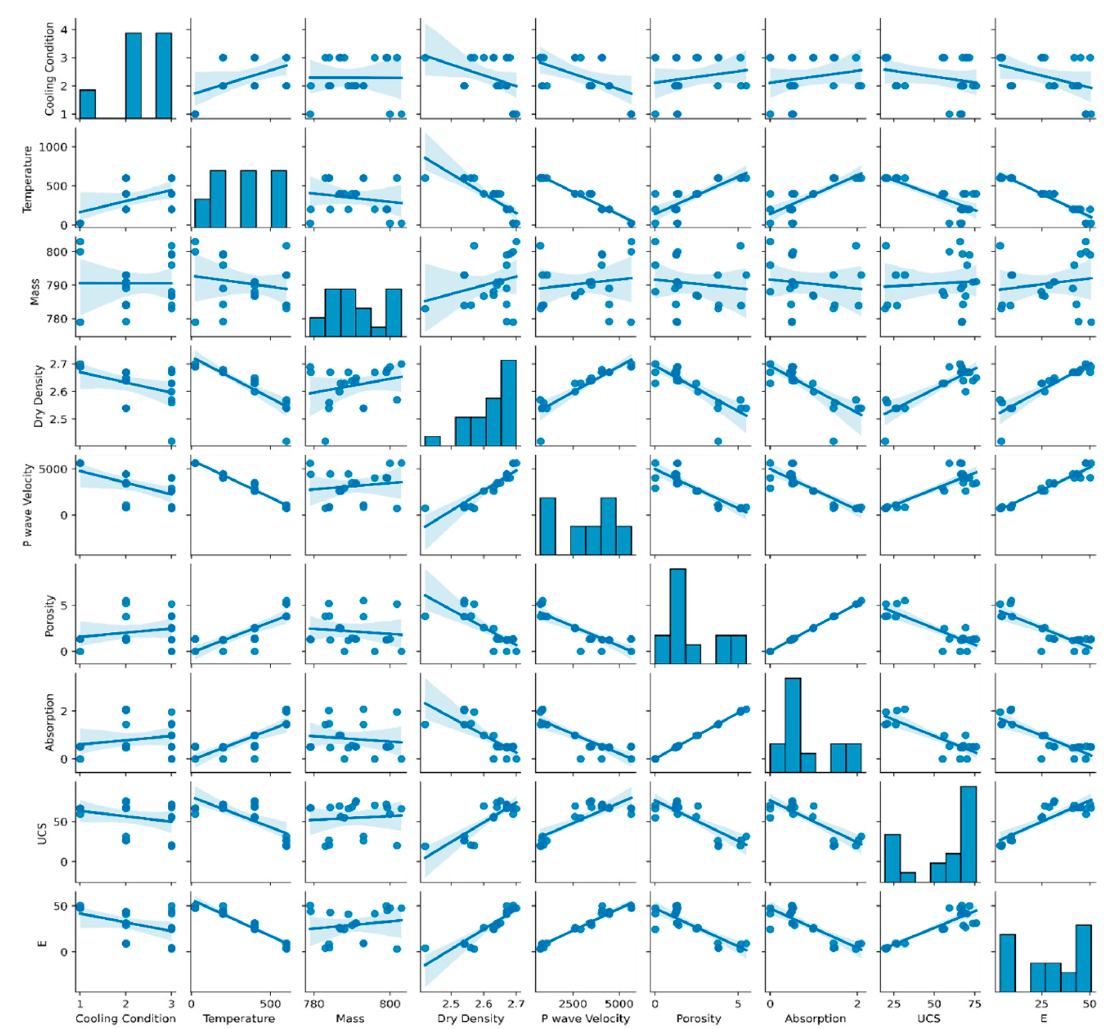
Figure 5. Input and output distributions as a pairwise correlation matrix.